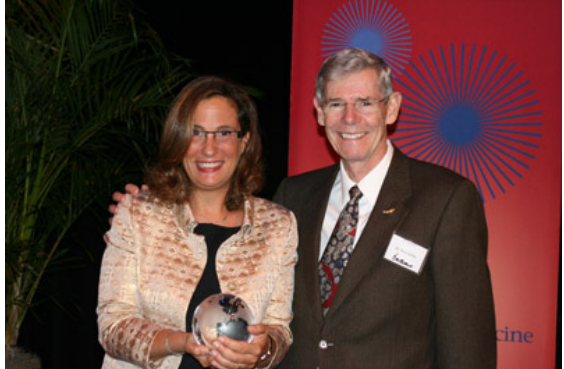
Figure 1. Dr. Ilara Capua and Dr. Paul Gibbs during the ceremony for the Penn Vet World Leadership in Animal Health award conferred by the University of Pennsylvania (USA) in 2011.